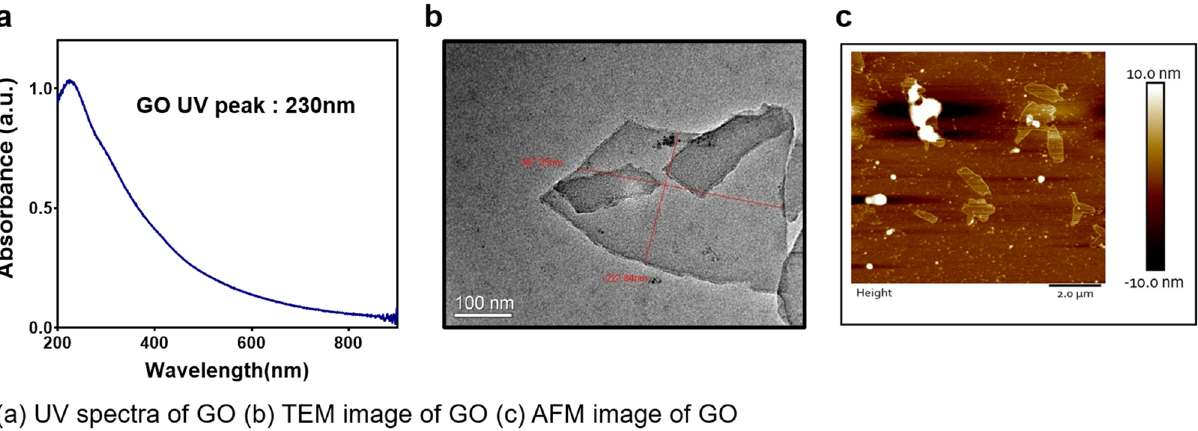
Figure 2. Characterizations of synthesized Graphene Oxide. ( a ) UV spectra of GO ( b ) TEM image of GO ( c ) AFM image of